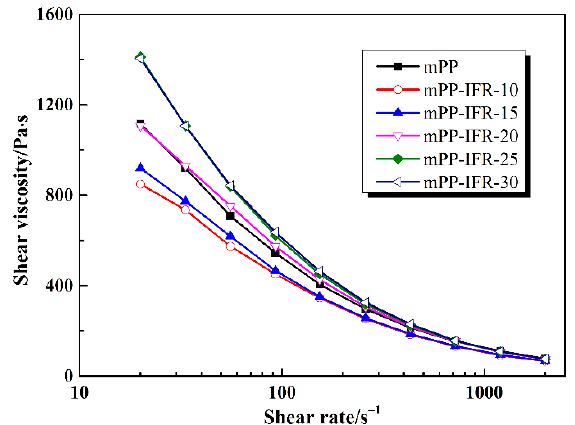
Figure 1. The rheology curves of polypropylene melts with different flame retardant content at 230 °C.